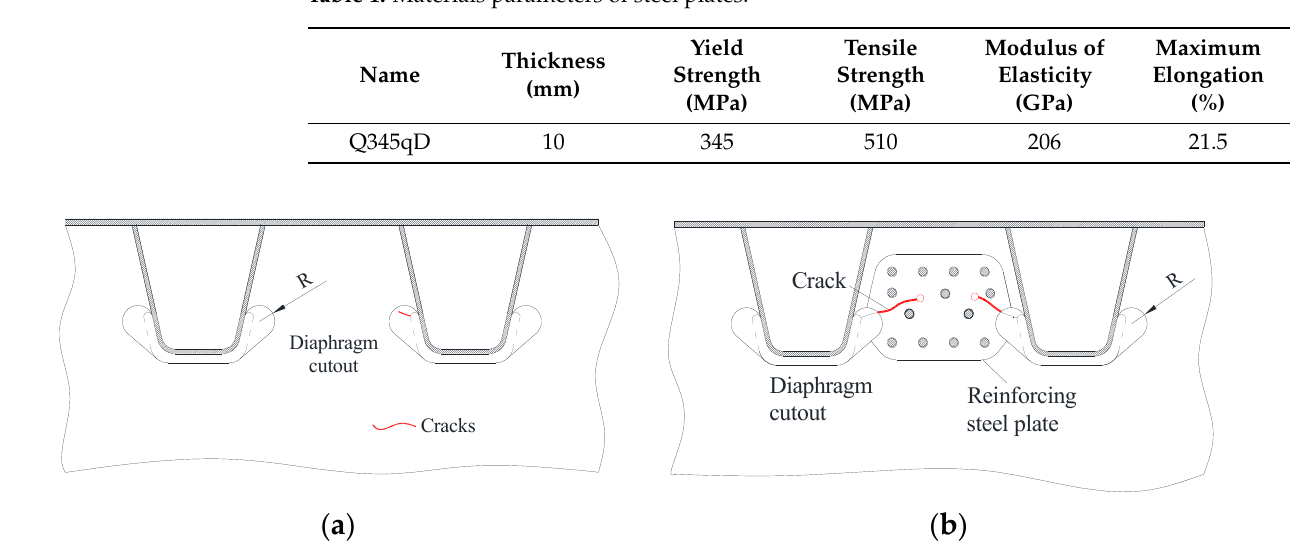
Figure 4. Finite Element Model of Steel Box Girder. In this work, the Chinese specification “Design Code for Highway Steel Bridges” (JTG D64) standard vehicle is used for loading, and the loading vehicle is shown in Fig- ure 5. Wheel load acts directly on the steel bridge panel, according to the thickness of the